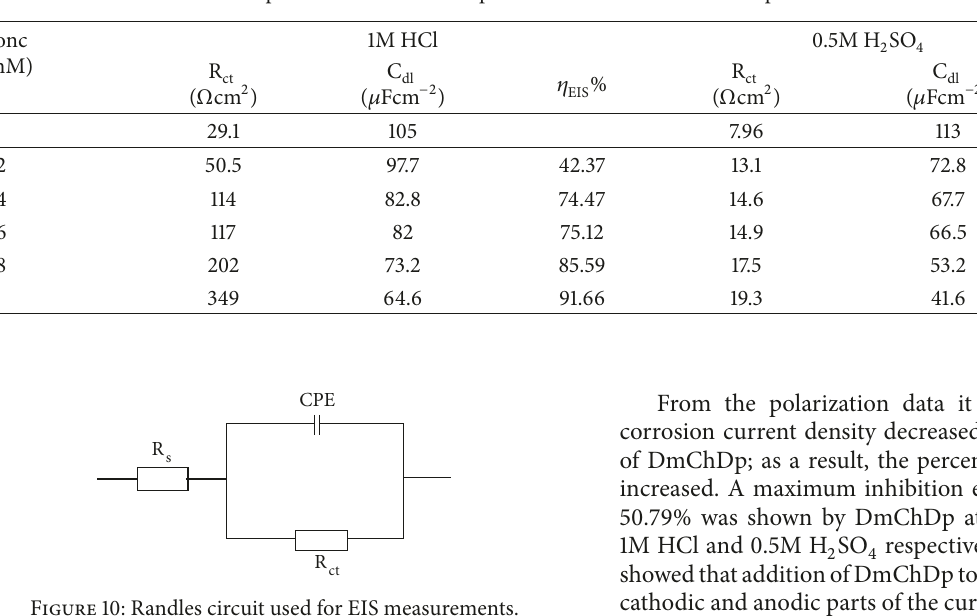
Figure 9: Bode plots of MS coupons with and without DmChDp in (a) 1M HCl and (b) 0.5M H 2 SO 4 . Table 4: Impedance data of MS coupons with and without DmChDp in 1M HCl and 0.5M H 2 SO 4 .